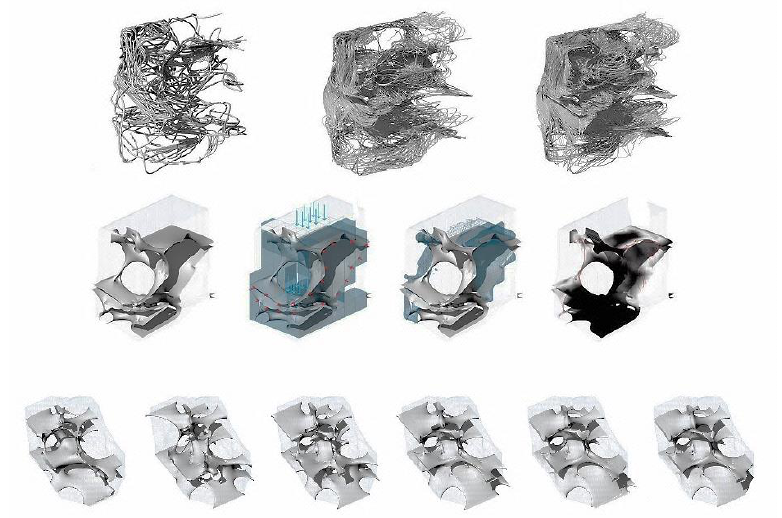
Figure 6. The design system of the prototypes is a combination of multi-systems. Each of them is produced based on the form of another and interact with each other under certain